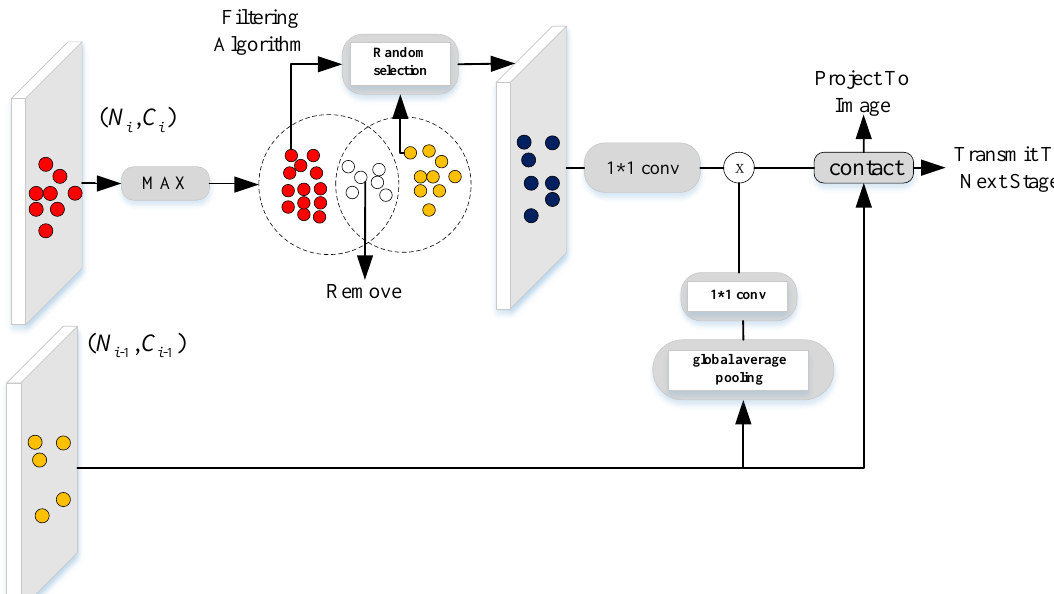
Figure 2. The general mechanism of our CMF module. This scheme consists of two main procedures: multi-scale fusion and LIDAR-RGB projecting.